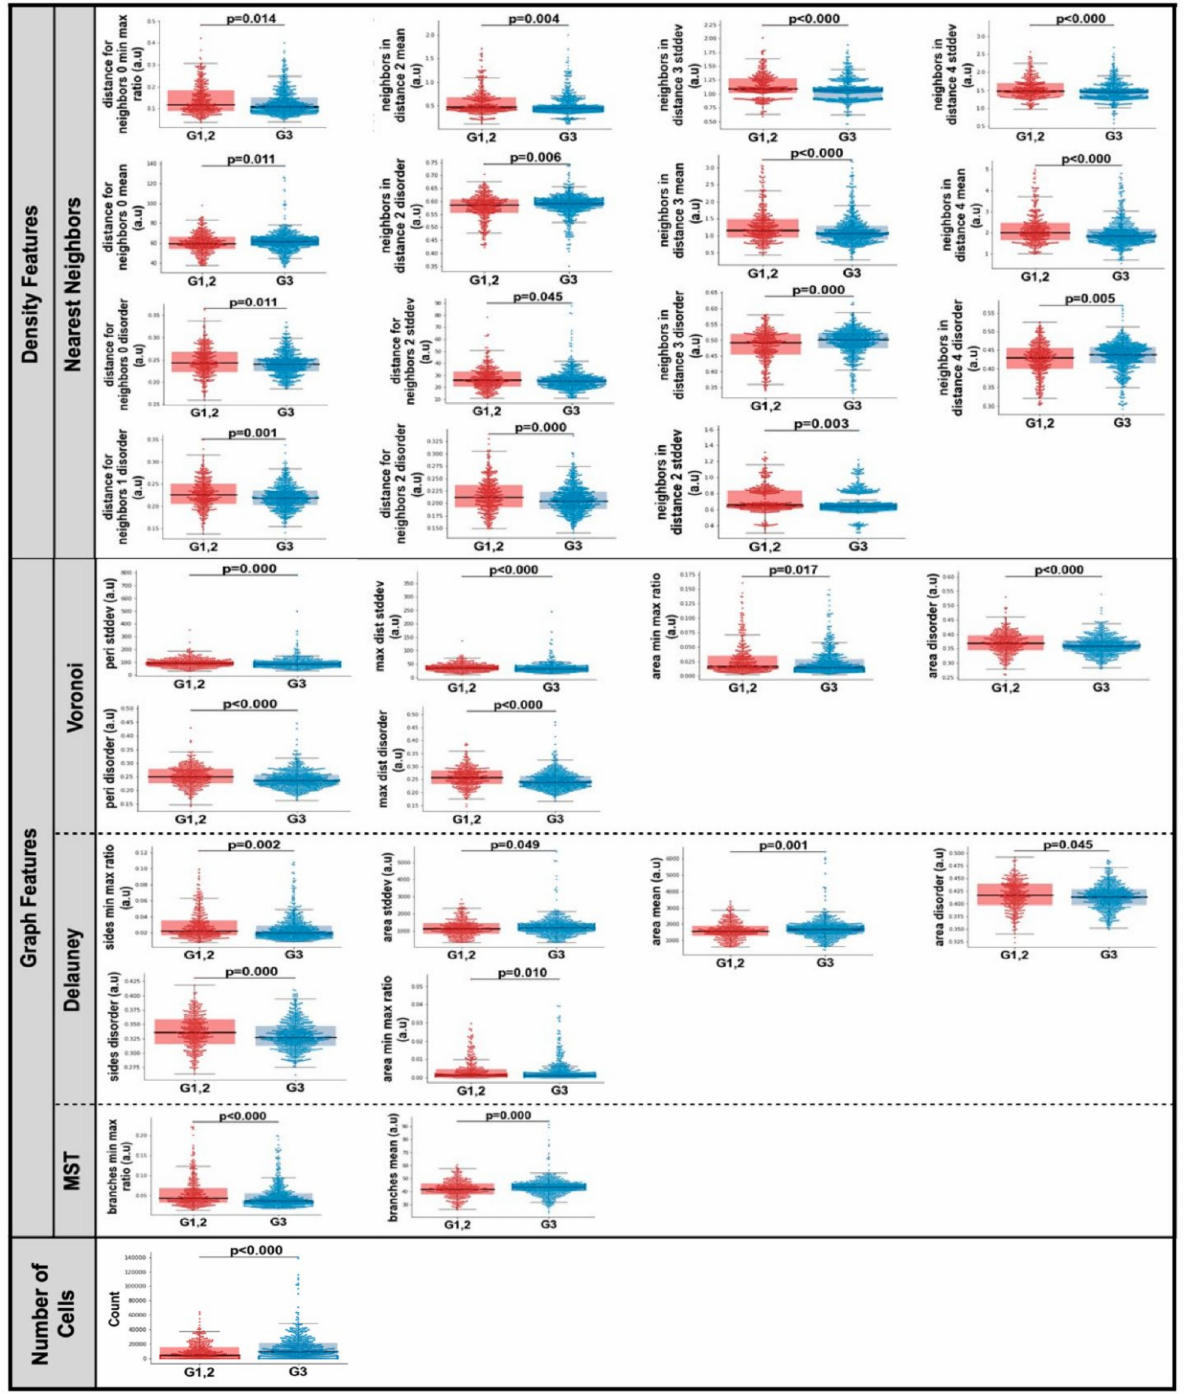
Figure 3. Combined box and whisker and swarm plots of the statistically significant ( p < 0.05) spatial features. Abbreviations: stddev, standard deviation; Min, minimum; Max, maximum; MST, Minimum Spanning Tree; a.u., Arbitrary units; G1, 2, Nottingham grade 1 and 2; G3, Nottingham grade